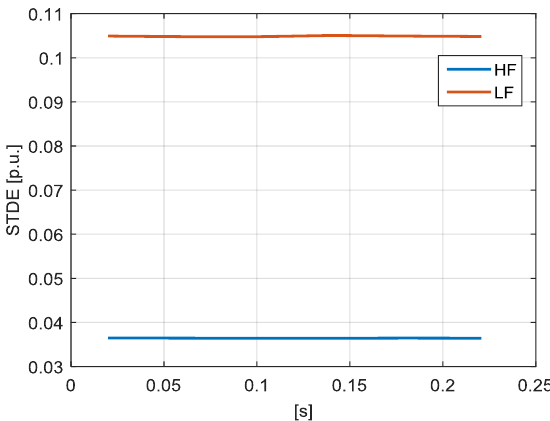
Figure 25. Case study 1: STDE at low-frequency (0 ÷ 2 kHz, red line) and at high-frequency (2 ÷ 150 kHz, blue line) obtained through STFT.